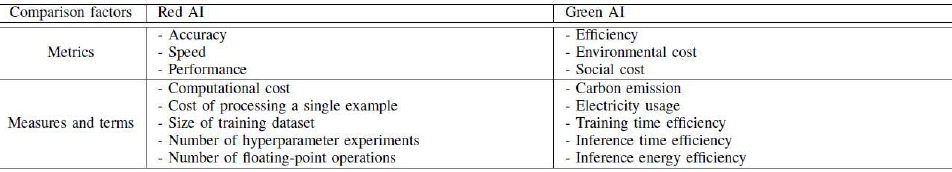
Figure 1. Comparison of Red AI and Green